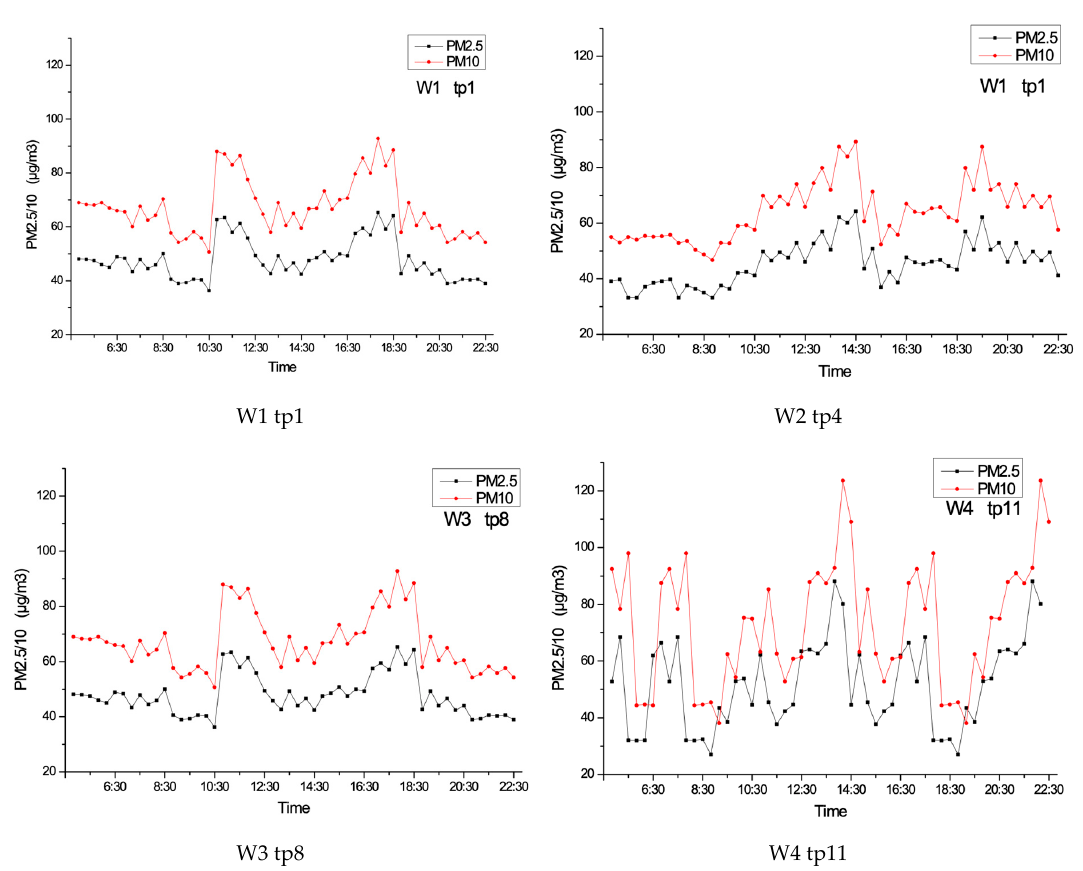
Figure 13. Comparison curves of hourly particulate matter 2.5 (PM2.5)/PM10 concentration data for each point during the monitoring day.